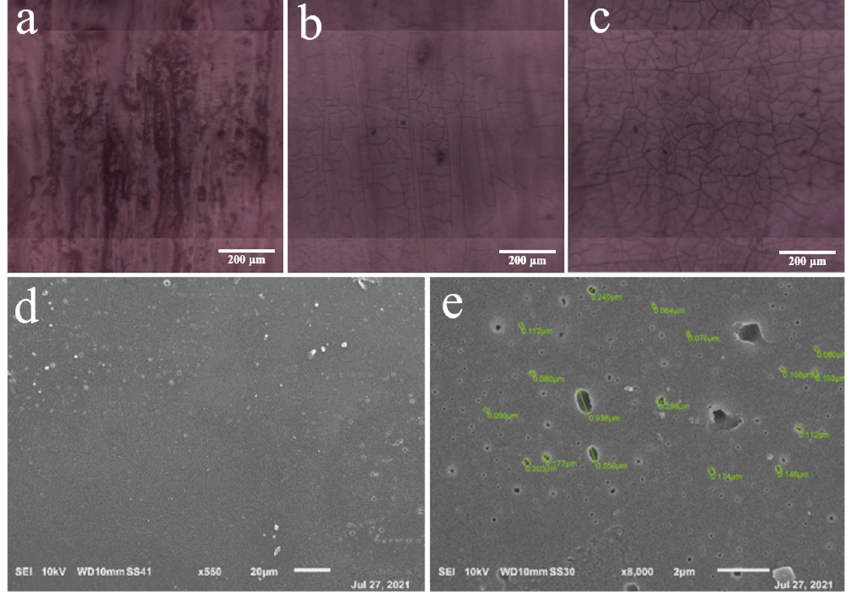
Figure 3. Pictures of measurement areas: ( a ) WPU-3:1, ( b ) WPU-1:1 and ( c ) WPU-1:3. SEM images of PU-3:1 ( d , e ).